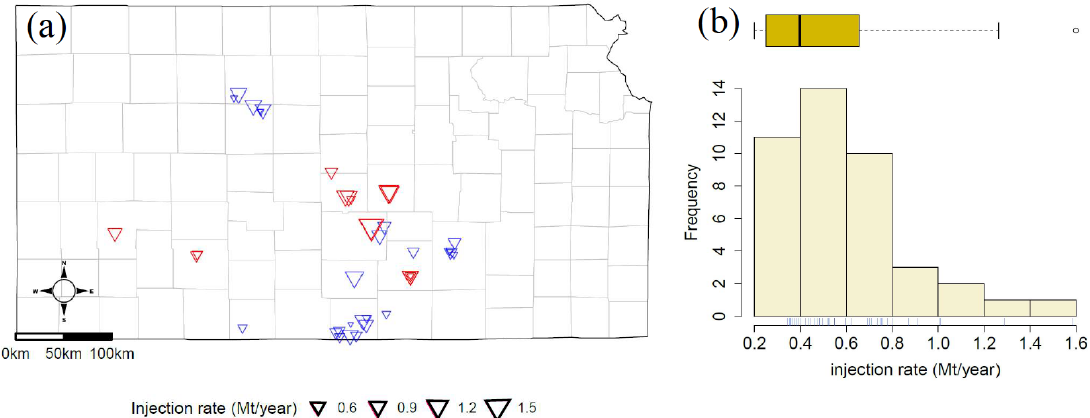
Figure 2. ( a ) Wells injecting more than 0.34 Mt/year of waste fluid into the Arbuckle aquifer across Kansas. The red triangles show Class I and the blue triangles show Class II injection wells. ( b ) Histogram of injection rates for the wells injecting >0.34 Mt/years waste-fluid across Kansas (circles indicate outliers).